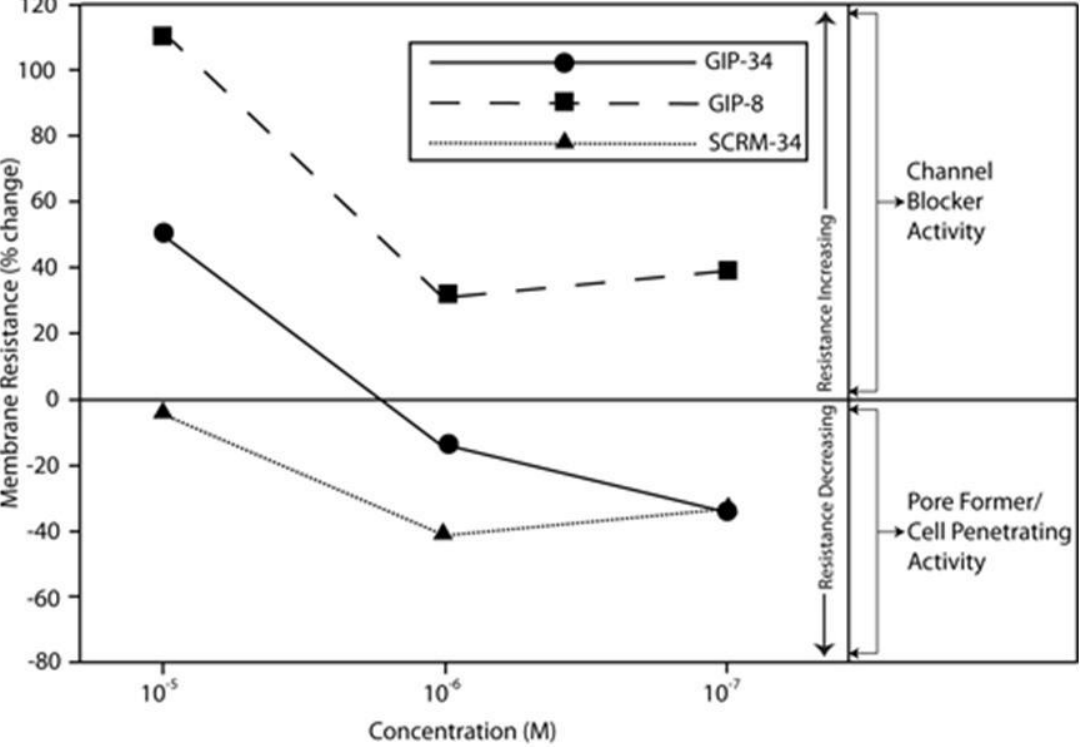
Figure 2. Growth Inhibitory Peptides (GIP-34, GIP-8, and a 34-mer scrambled (SCRM) peptide were evaluated for acute effects on cell membrane potential (current) and membrane resistance in cultured human breast cancer cells. MCF-7 cells were impaled in vivo with sharp microelectrodes under inverted phase contrast